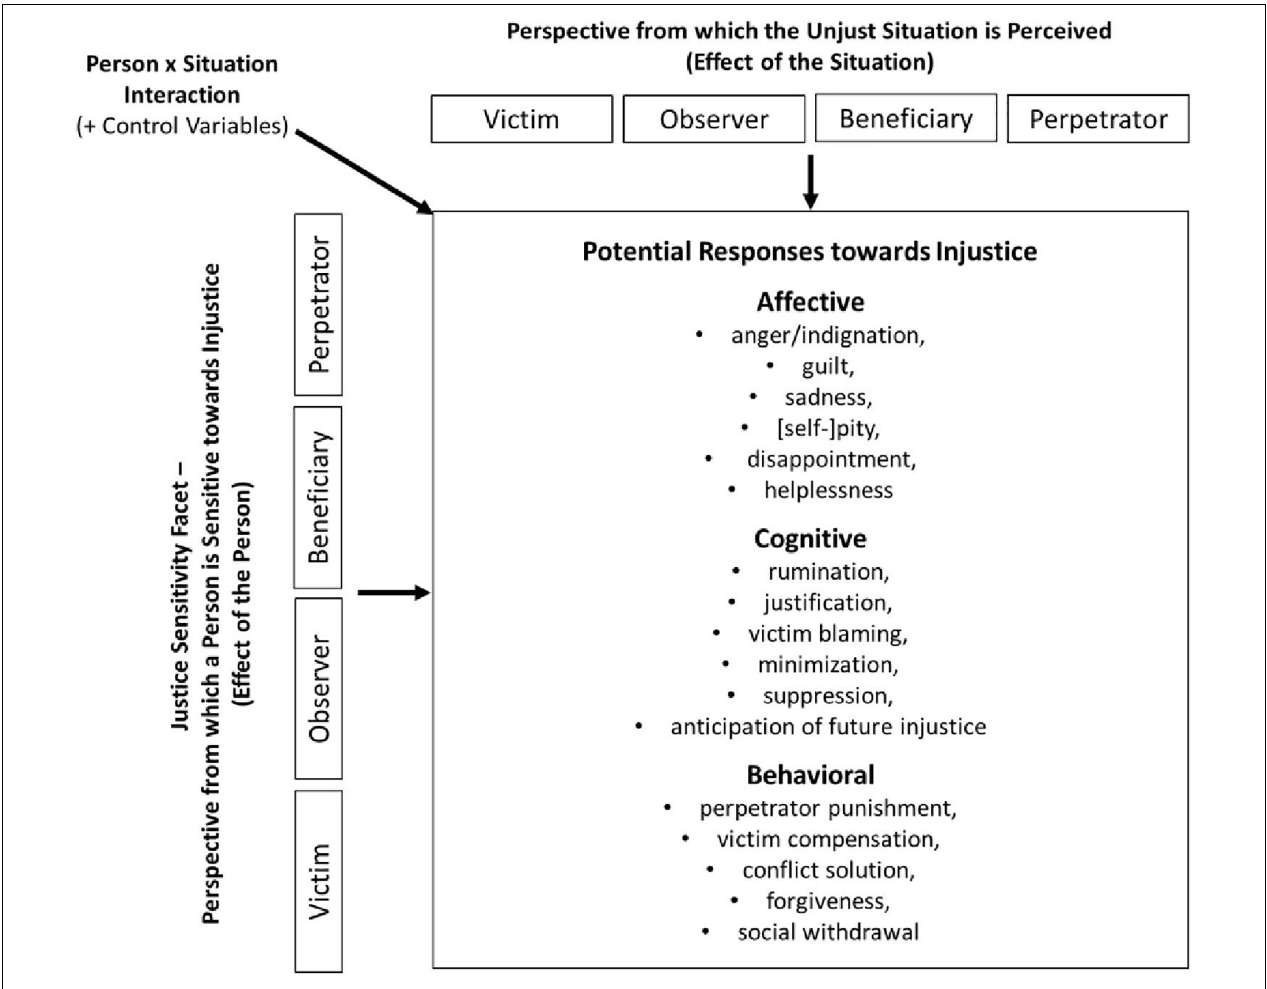
FIGURE 1 | Research design of the current